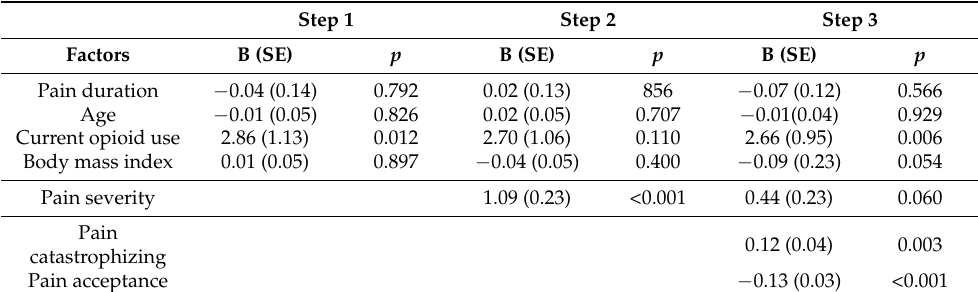
Table 3. Multivariate hierarchical regression predicting self-report physical functioning limitations.